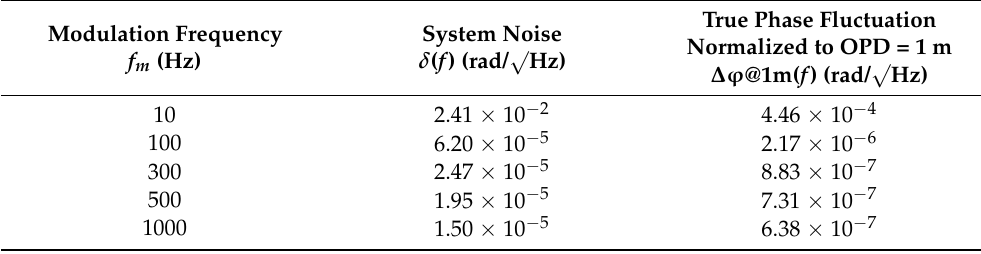
Table 2. The PSD values of the background noise and the true phase fluctuation normalized to OPD = 1 m at different modulation